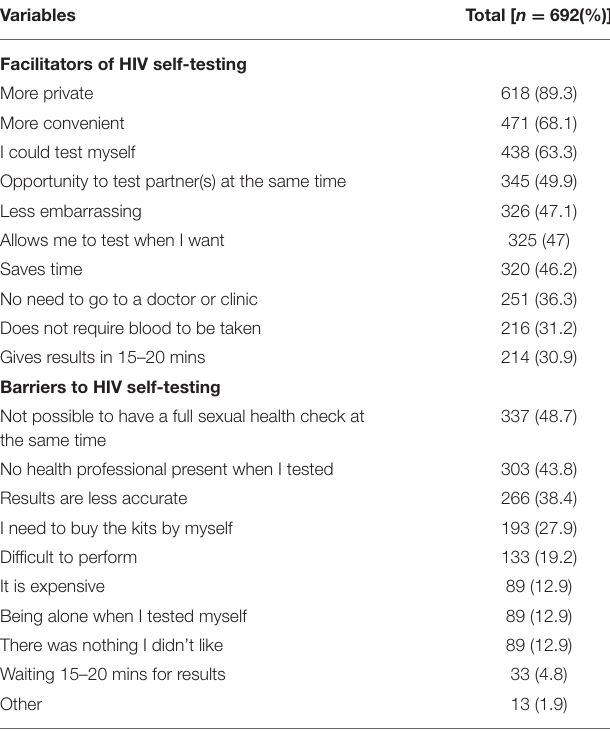
TABLE 5 | Facilitators and barriers to HIVST uptake among MSM in Jiangsu province of China, 2020. Variables Facilitators of HIV